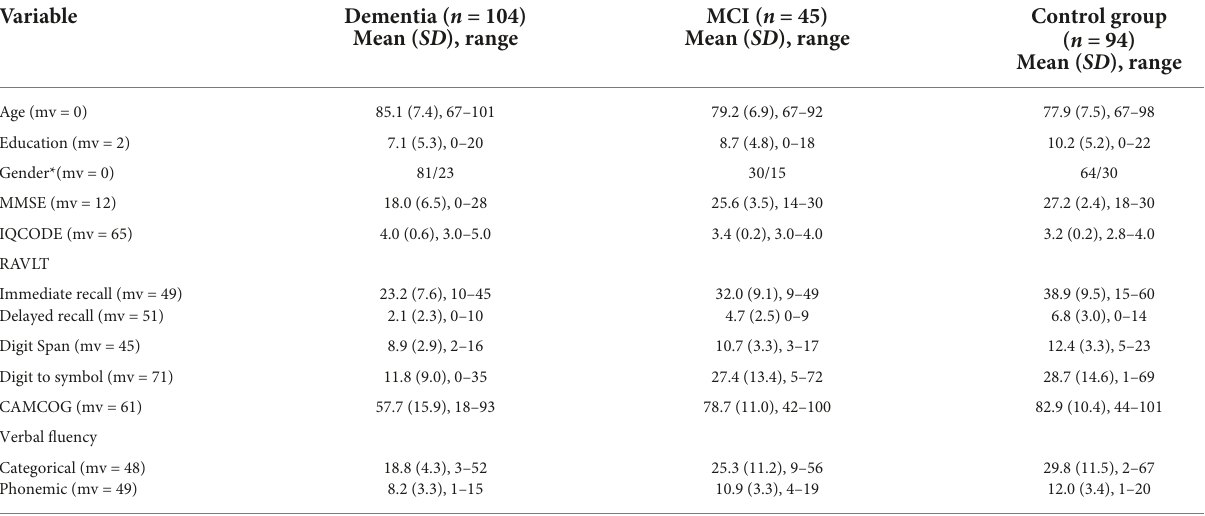
TABLE 1 Sociodemographic and clinical characteristics of participants.